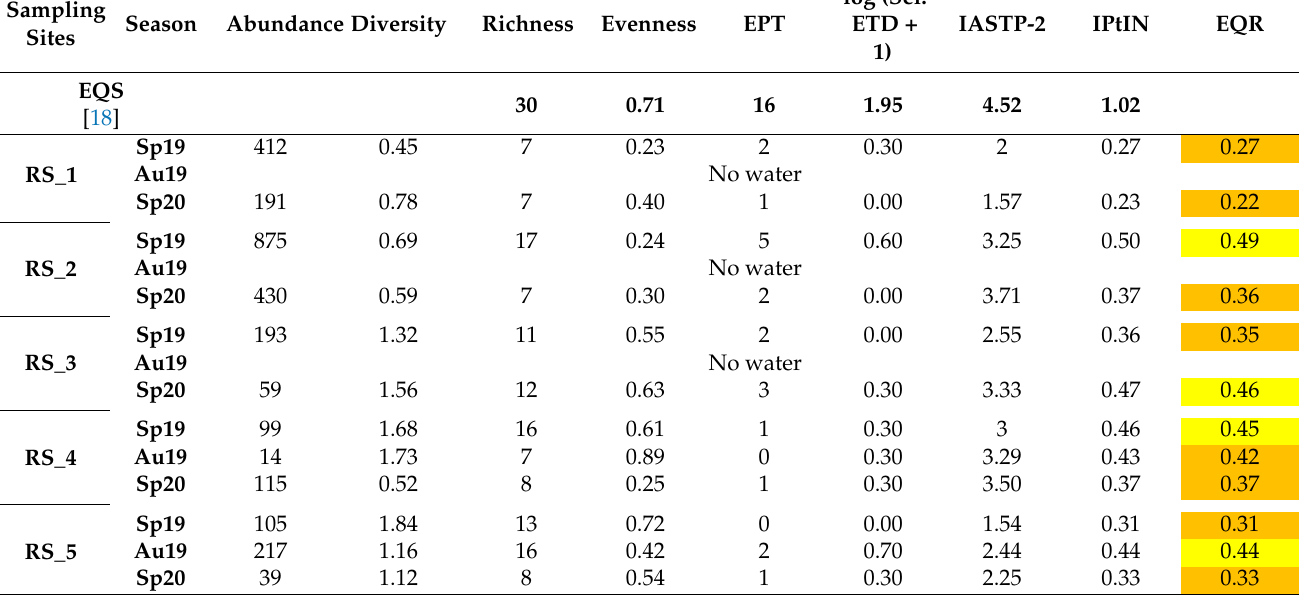
Table 3. Values obtained and Environmental Quality Standards (EQS) of WFD stipulated for small rivers in the North that make up the IPtlN and the respective Ecological Quality Ratio (EQR) for each sampling site and period regarding the macroinvertebrate communities. Different colors stand for the EQR classification (derivation of EQR from IPtIN; see Section 2.4.2).